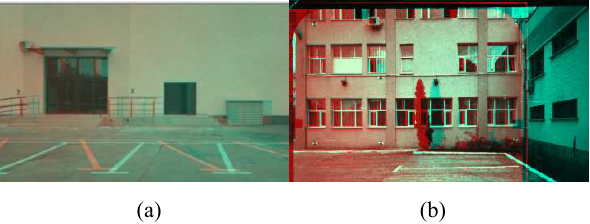
Figure 6 – Stereoscopic viewing (a) North facade, (b) North East